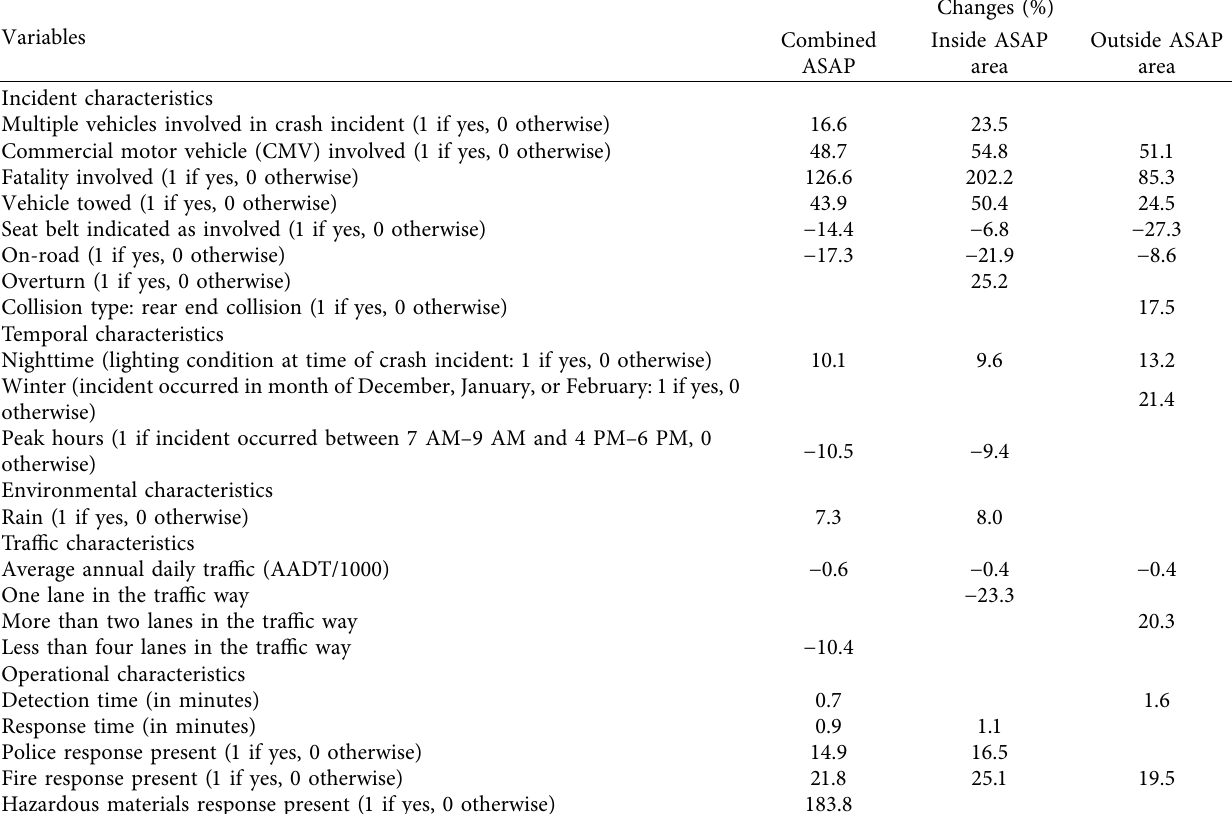
Table 3: Percent changes in the random parameters hazard-based duration